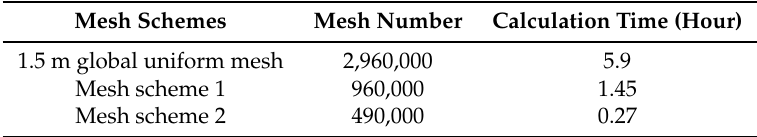
Table 5. Mesh number and calculation time.